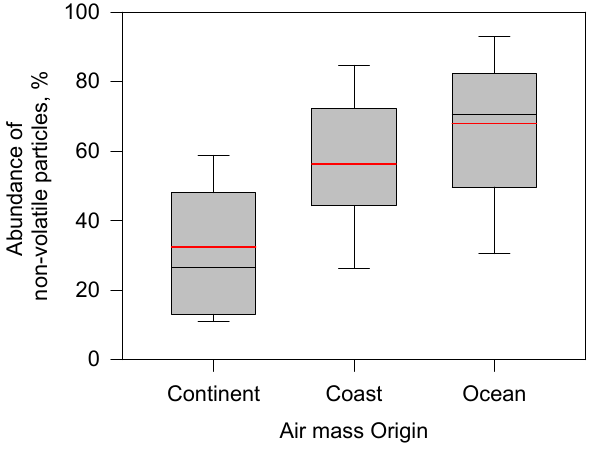
Fig. 11. Number fractions of non-volatile particles in each air mass origin during May–September. The upper bar, upper box line, black middle box line, bottom box line, and bottom bar respectively de- note values of 90%, 75%, 50% (median), 25% and 10%. The red line represents mean